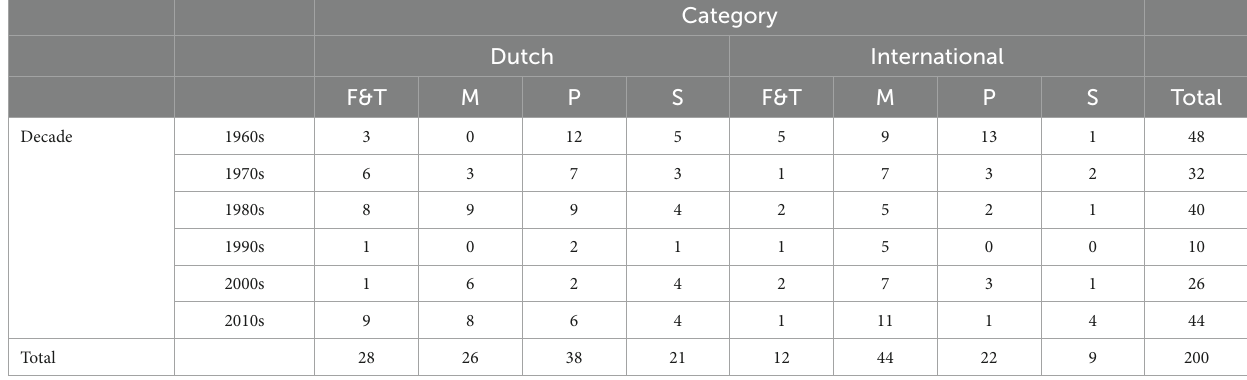
TABLE 4 Distribution of Dutch and international famous faces included in the 10 D-FFT versions in step 5 (excl. trial